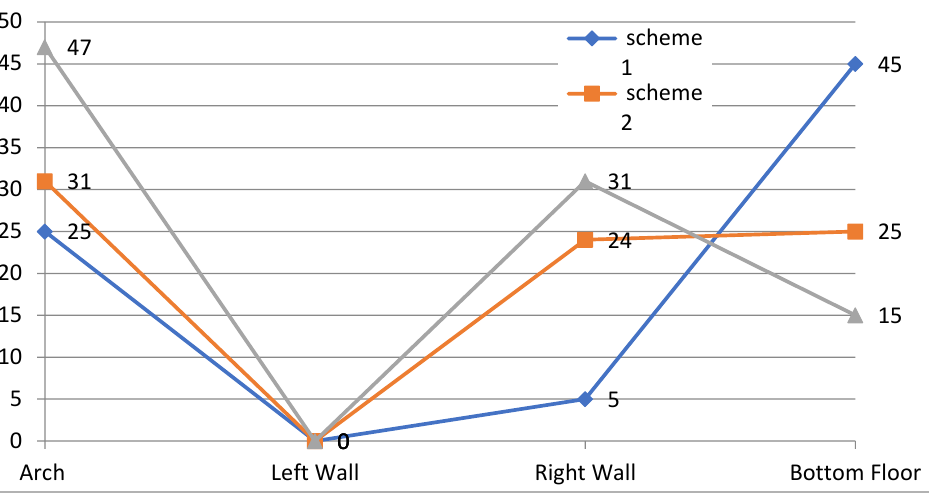
Figure 10. Crack depth (m) of SR after excavation of tailrace surge tank.